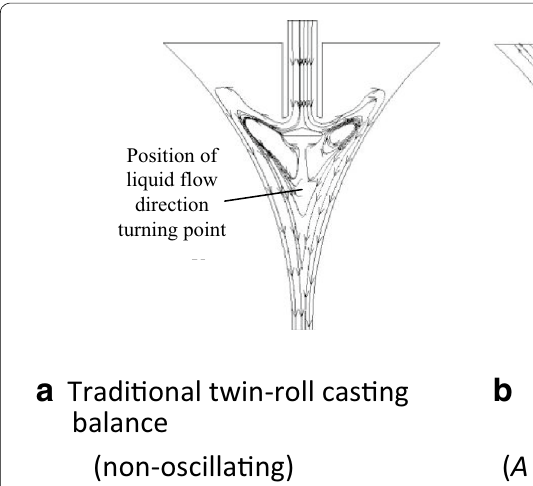
Figure 3 Stream line in the pool for different roller positions